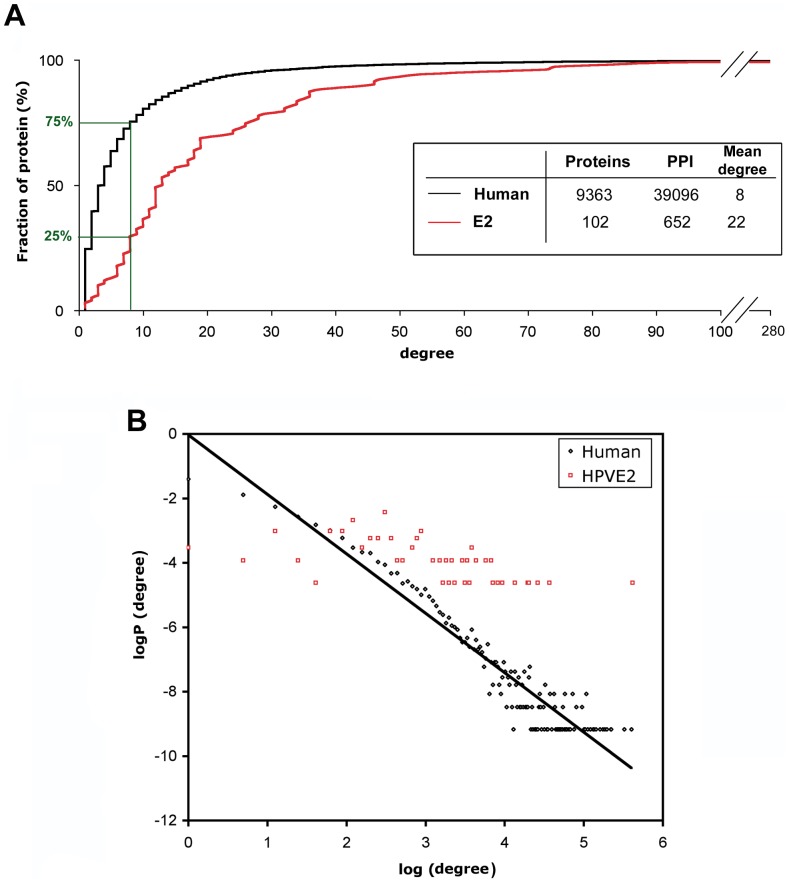
Topological analysis of the E2 interaction network.(A) Cumulative distribution of node degree of a reconstructed human interactome (black curve) and the E2 interactome (red curve). The fraction of proteins under the estimated average degree of the human interactome (8) is represented. The characteristics of each interactome are given in the inset. (B) Distribution of degree probability of the human (black) and the E2 interactome (red). P(degree) is the probability to connect K other proteins in the network. For the human interactome, the straight line represents the linear regression fit of the data (with a correlation coefficient R2 = 0.91). For the E2 interactome, we could not fit the data to a linear regression (R2 = 0.34).